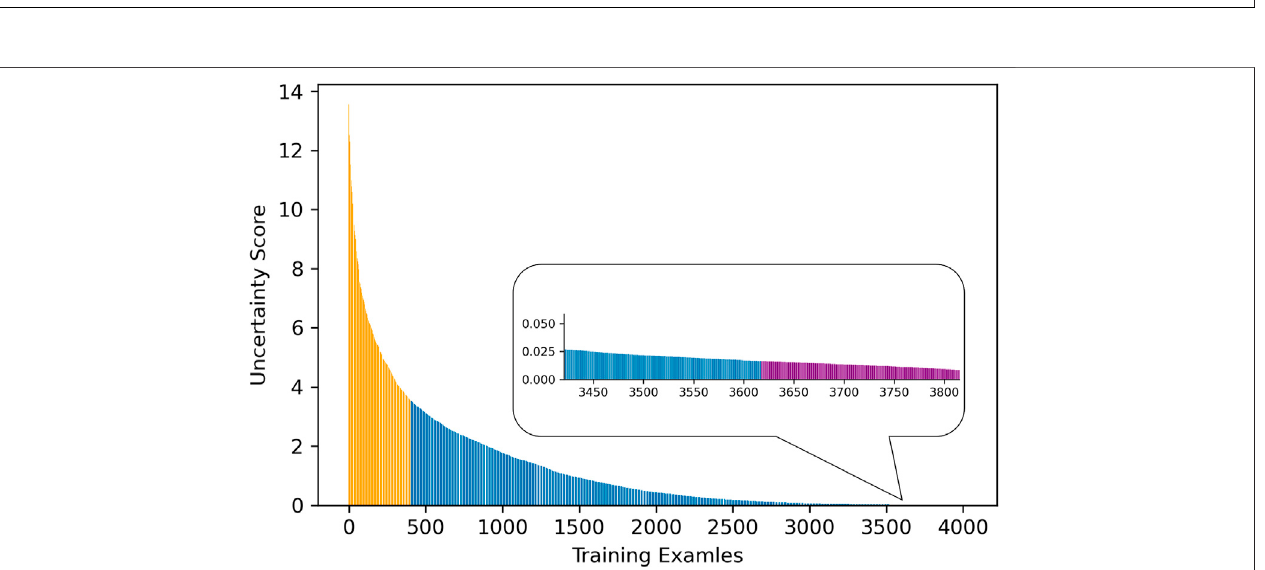
FIGURE 4 | The distribution of 10% examples with the highest and lowest uncertainty scores.